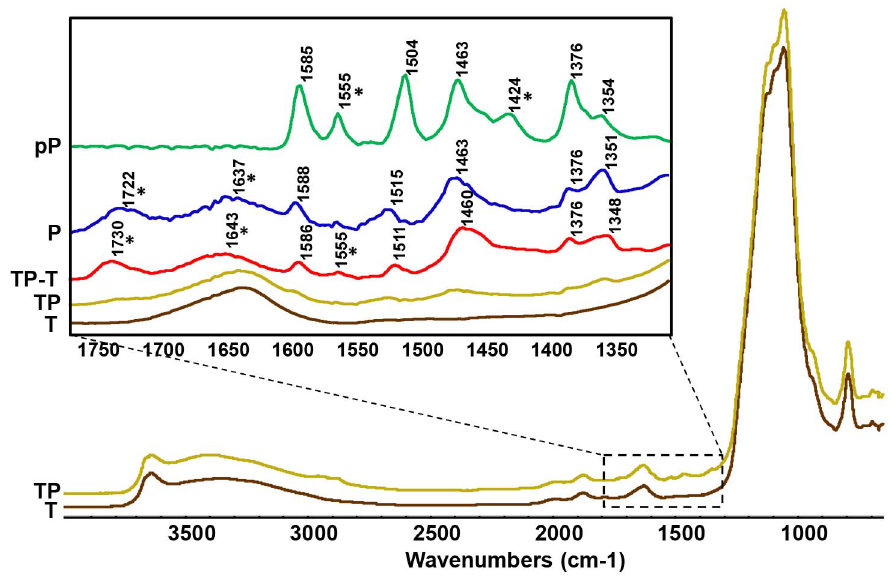
Figure 5. FTIR. Diffuse Reflectance (DR- FTIR) spectra of (T) Turface and (TP) Turface saturated with Pcz are shown in the 4000 to 700 cm 2 1 region. An expanded plot showing the spectra features of interest are plotted in the inset from 1750 to 1350 cm-1 showing the DR-FTIR spectra of (T), (TP), and (TP-T) the spectral subtraction of (TP) – (T). For comparison, the Attenuated Total Reflectance (ATR-FTIR) spectrum of (P) Pcz and (pP) pure Pcz are shown. The bands marked by a (*) are spectral features influenced by the presence of the surfactant in (P) Pcz.